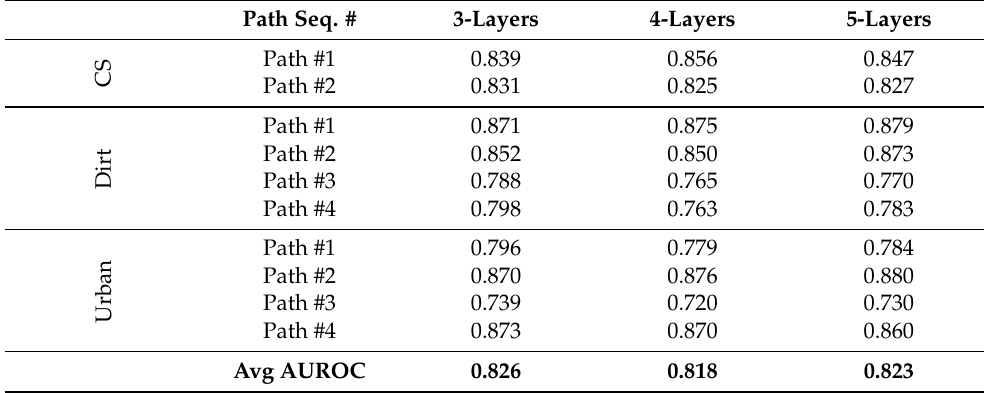
Table 1. Performance evaluation of localizer L obtained by changing its number of layers for the detection task. Reported scores refer to the AUROC metric.